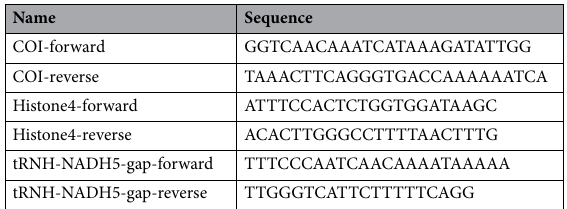
Table 1. Primers used in the